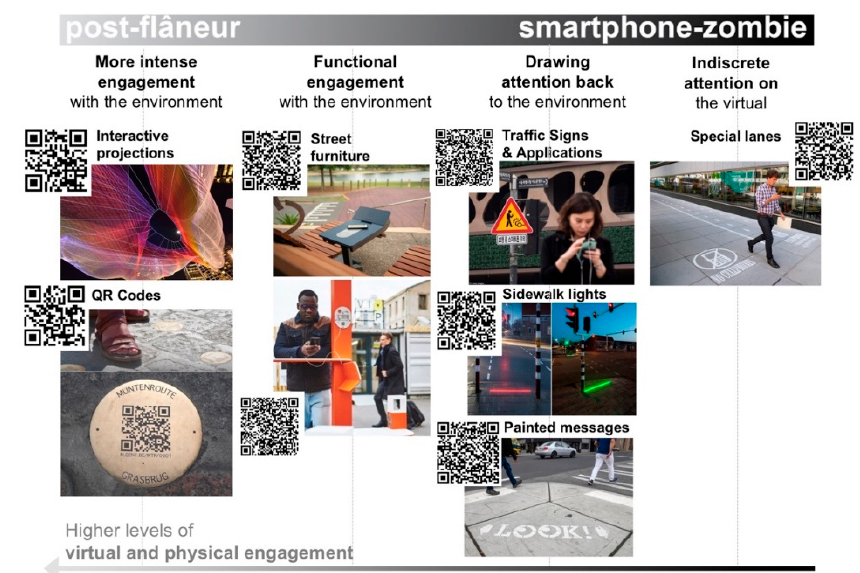
Figure 2. Existing public space design interventions addressing smartphone users [51–58] (original figure by the authors, images used can be reached through the references and QR codes).